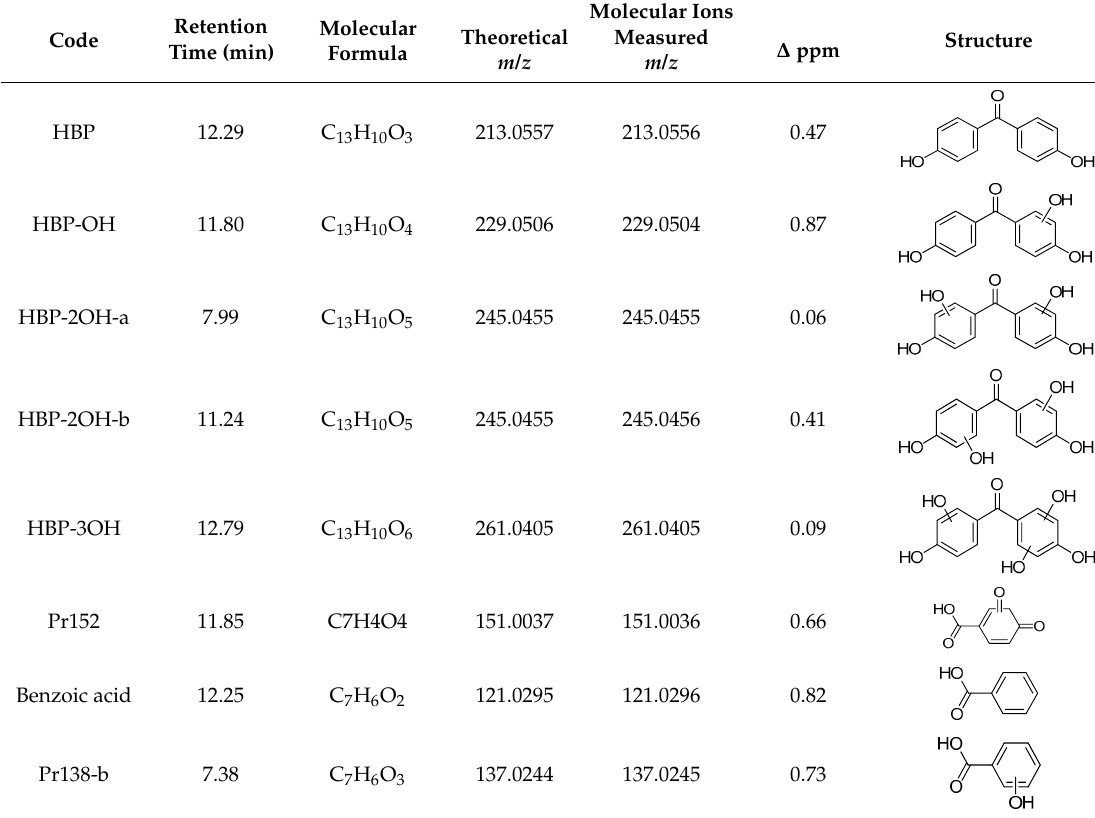
Table 6. Molecular formula and properties of HBP and its degradation products.